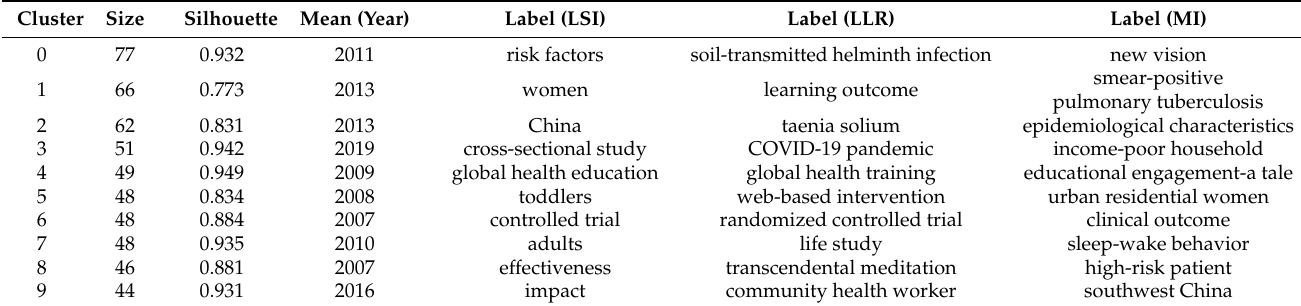
Table 4. The largest 10 clusters of HE document